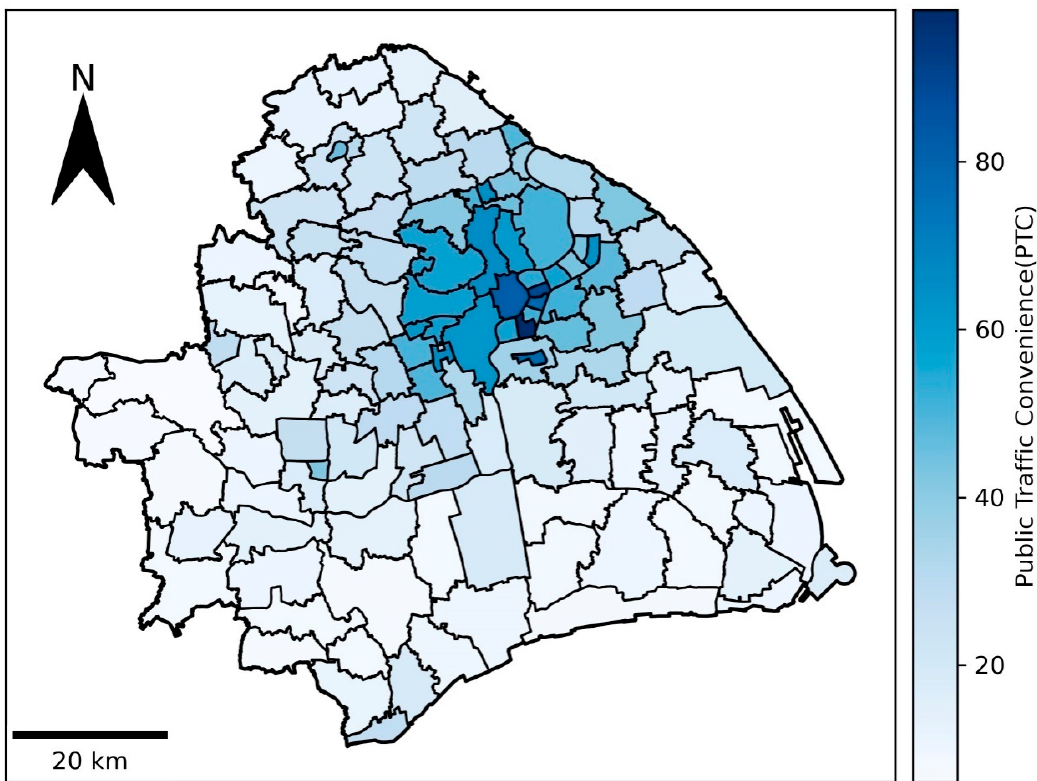
Figure 3. Calculation results for various public transportation conveniences in the sample study area.